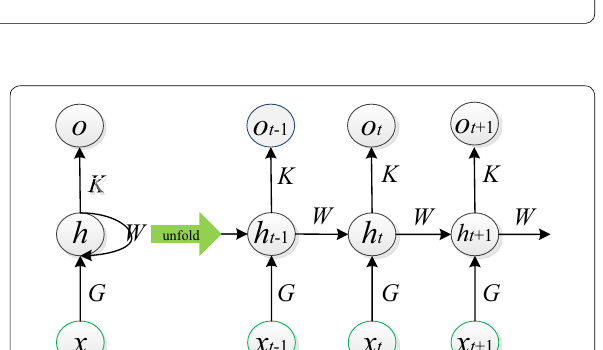
Figure 8 Architecture of recurrent neural network